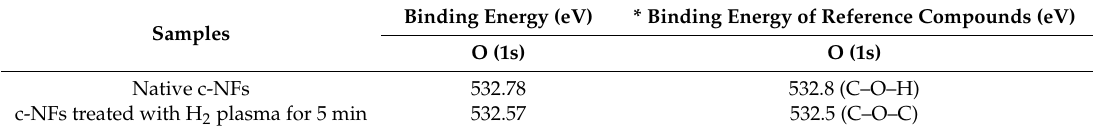
Table 4. X-ray photoelectron spectroscopy (XPS) characterization of native and plasma-treated c-NFs samples.